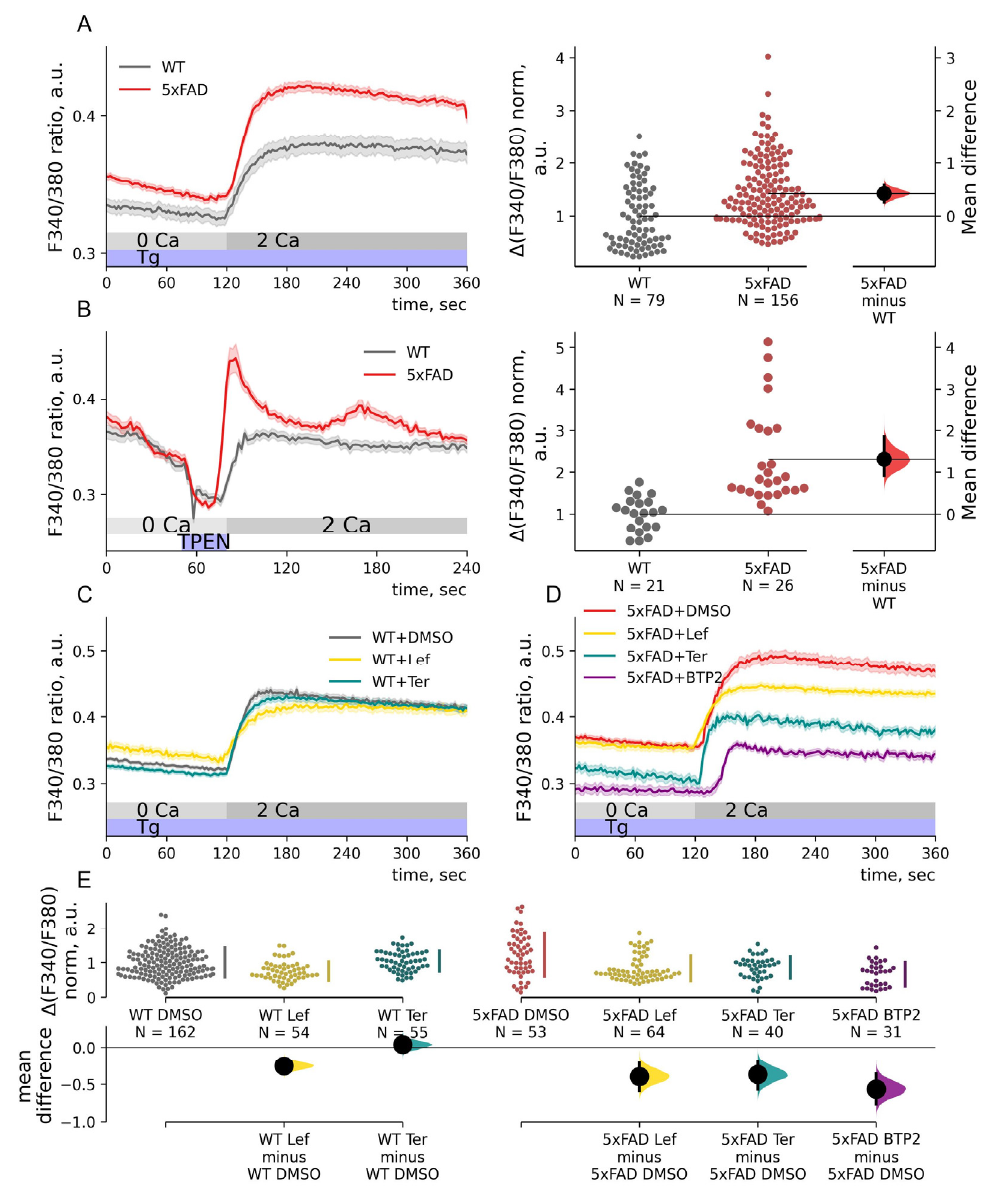
Figure 1. Effect of inhibitors Leflunomide, Teriflunomide, and BTP2 on elevated store-operated calcium entry in hippocampal neurons from 5XFAD mice. ( A , B ) Calcium imaging with Fura2 of neurons of primary hippocampal cultures of wild-type (WT, gray) or 5xFAD (red) mice. Mean traces of F340/380 ratio are represented as mean ± SEM. Calcium entry ( ∆ F340/F380) was calculated as the F340/F380 peak of each trace after Ca 2+ add-back, and the baseline was subtracted. ∆ F340/F380 data were normalized by the mean WT calcium entry and shown in the estimation plots. WT and